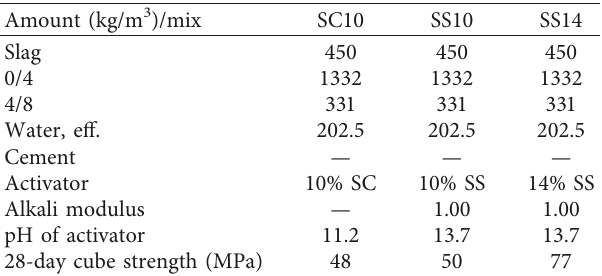
Table 2: Mix proportions and mix